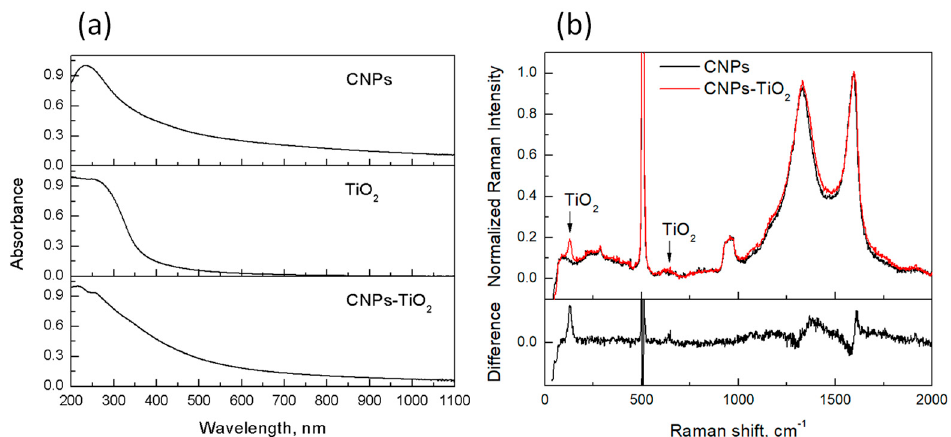
Figure 3. Normalized UV-vis light absorption spectra ( a ) and Raman spectra ( b ) for CNPs, TiO 2 and CNP-TiO 2 film. In ( b )—lower panel—the difference between the normalized Raman spectra of CNP-TiO 2 and CNPs is also shown. Signals near 500 cm − 1 and 1000 cm − 1 in ( b ) are due to the Si